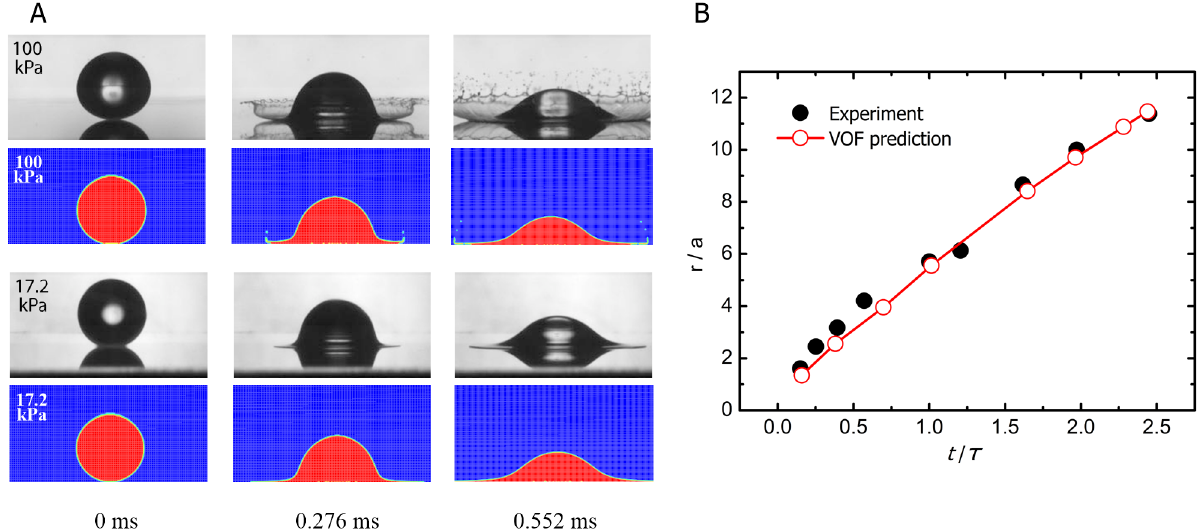
Fig 2. Droplet impact characteristics. A 3.4 ± 0.1mm diameterethanolliquiddrop impacting a smoothdry substrate at U 0 = 3.74 ± 0.02m/s in the presenceof differentbackgroundair pressures. A. The experimental shapesfor a sphericaldroplet[11]are in black color and the predictedshapesfor an infinitecylindricaldropletare in red. In the top andsecondrows, with the air pressureof 100 kPa, the drop splashes. In the third and fourth rows, under air pressure of 17.2 kPa, there is no splashingat the peripheryof the rim. B. Comparison of the radial trajectory of the first ejected droplets impacting a dry solid surface obtained by the experiment andthe current VOF prediction.